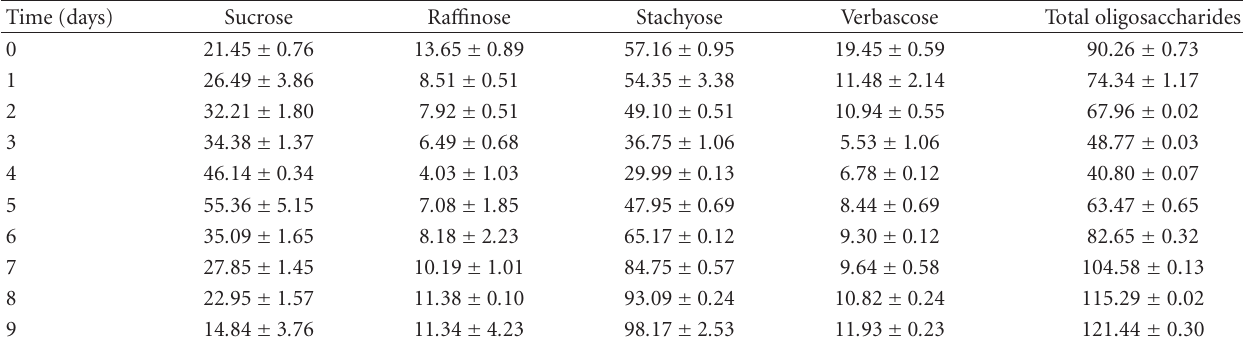
Figure 2: Sodium dodecyl sulfate polyacrylamide gel electrophoresis (SDS-PAGE) of present proteins in the L. campestris germinated seed. S = standards (kDa). Table 1: Behavior of carbohydrates of the L. campestris germinated seed (mg/g of